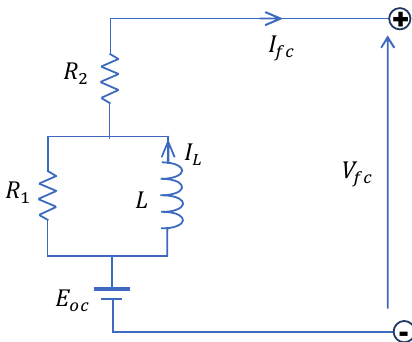
Figure 5. Comparison between the shape of the experimental FC voltage with the equivalent RC circuit.